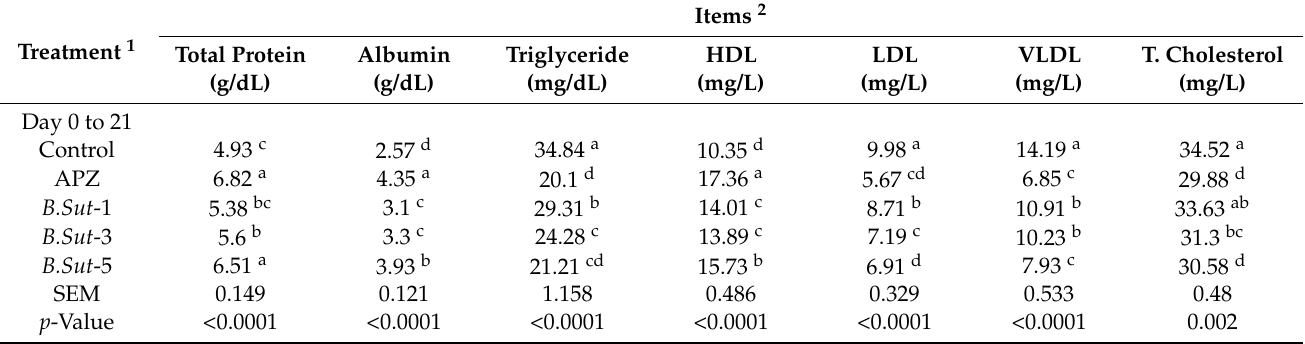
Table 3. Effect of the addition of Bacillus subtilis into broiler diets on serum biochemical blood of broiler chickens at 21st and 42nd days